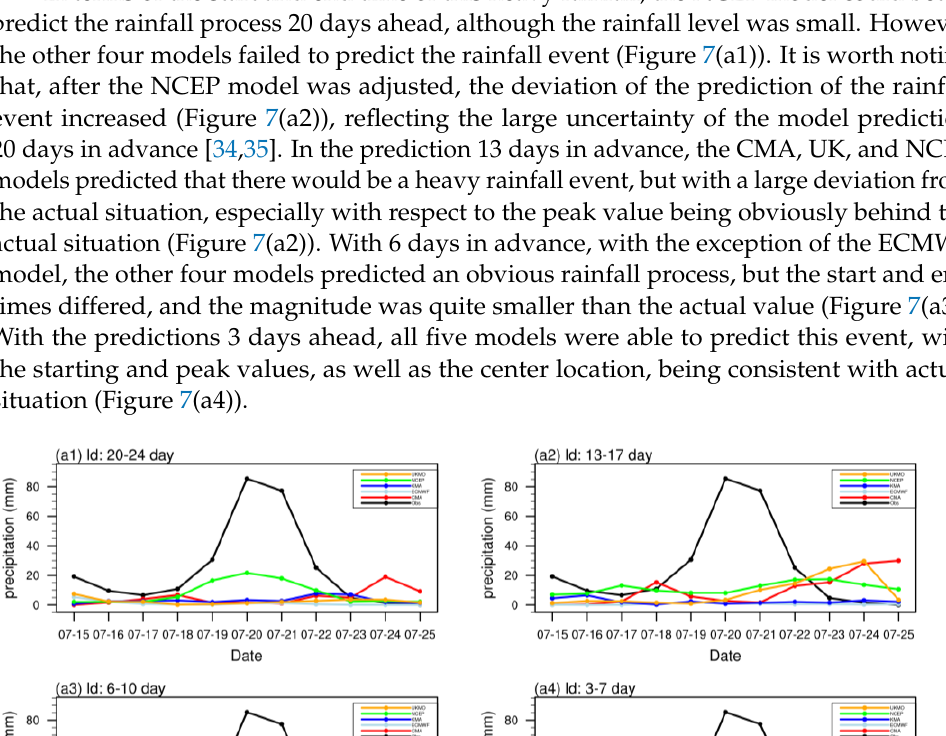
Table 4. RMSE of cumulative rainfall prediction during 18 – 22 July in Henan.